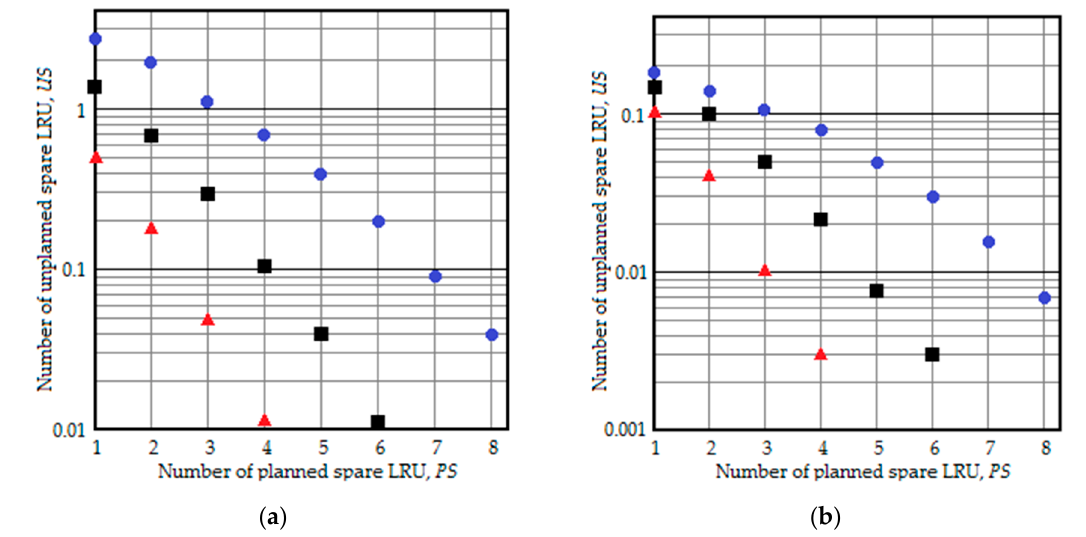
Figure 5. Dependences of the expected unplanned quantity of spare LRU ( US ) on the planned quantity of spare LRU ( PS ) for the first WM option when 𝜆 = 10 (cid:2879)(cid:2872) h (cid:2879)(cid:2869) ; ( a ) 𝑇 (cid:3006)(cid:3005) = 𝑇 (cid:3019)(cid:3020) = 120 h, red circles: 𝜃 = 10 (cid:2879)(cid:2872) h (cid:2879)(cid:2869) and 𝑃 (cid:3033)(cid:3039)(cid:3036)(cid:3034)(cid:3035)(cid:3047)(cid:3007)(cid:3017) = 10 (cid:2879)(cid:2872) , black squares: 𝜃 = 10 (cid:2879)(cid:2872) h (cid:2879)(cid:2869) and 𝑃 (cid:3033)(cid:3039)(cid:3036)(cid:3034)(cid:3035)(cid:3047)(cid:3007)(cid:3017) = 10 (cid:2879)(cid:2871) , blue circles: 𝜃 = 10 (cid:2879)(cid:2871) h (cid:2879)(cid:2869) and 𝑃 (cid:3033)(cid:3039)(cid:3036)(cid:3034)(cid:3035)(cid:3047)(cid:3007)(cid:3017) = 10 (cid:2879)(cid:2872) ; ( b ) 𝑇 (cid:3006)(cid:3005) = 40 h , 𝑇 (cid:3019)(cid:3020) = 120 h , red circles: 𝜃 = 10 (cid:2879)(cid:2872) h (cid:2879)(cid:2869) and 𝑃 (cid:3033)(cid:3039)(cid:3036)(cid:3034)(cid:3035)(cid:3047)(cid:3007)(cid:3017) = 10 (cid:2879)(cid:2872) , black squares: 𝜃 = 10 (cid:2879)(cid:2872) h (cid:2879)(cid:2869) and 𝑃 (cid:3033)(cid:3039)(cid:3036)(cid:3034)(cid:3035)(cid:3047)(cid:3007)(cid:3017) = 10 (cid:2879)(cid:2871) , blue circles: 𝜃 = 10 (cid:2879)(cid:2871) h (cid:2879)(cid:2869) and 𝑃 (cid:3033)(cid:3039)(cid:3036)(cid:3034)(cid:3035)(cid:3047)(cid:3007)(cid:3017) = 10 (cid:2879)(cid:2872) .